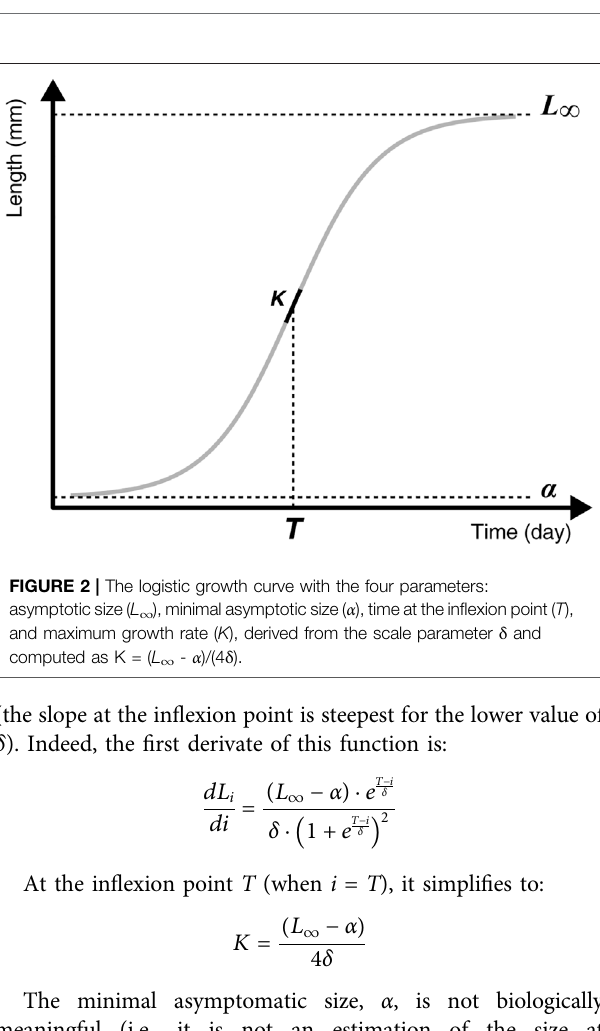
Frontiers in Environmental Science |